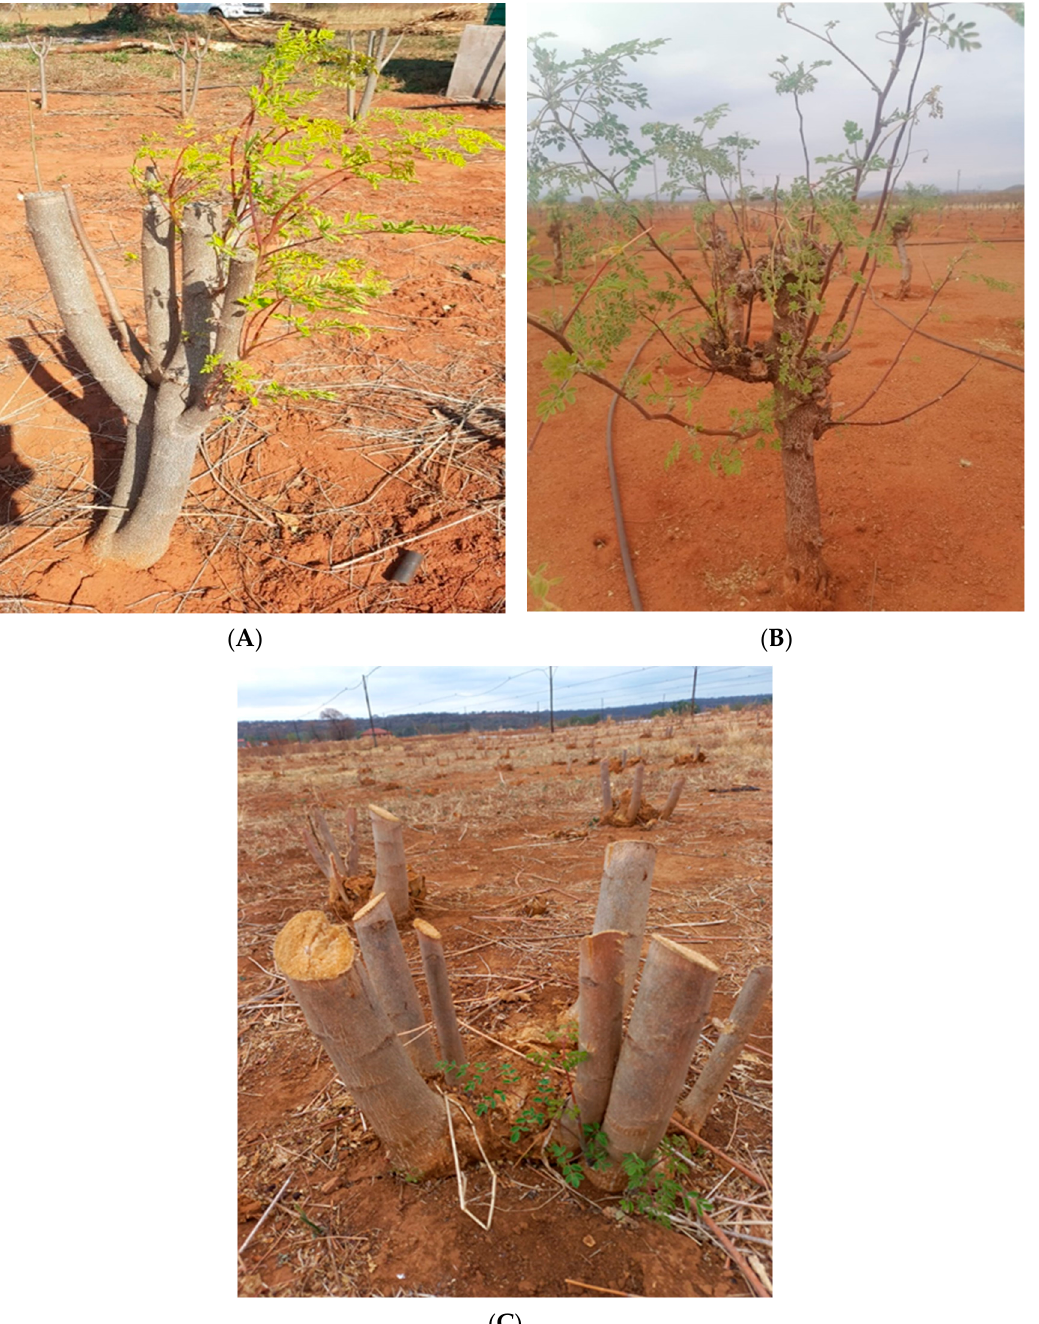
Figure 4. Pruning of Moringa oleifera at Vhembe District ( A ), Capricorn District ( B ), and ARC- Roodeplaat ( C ). Table 2 . ANOVA values and significant tests for the number of sprouts and length of Moringa oleifera from three agro-ecological zones.